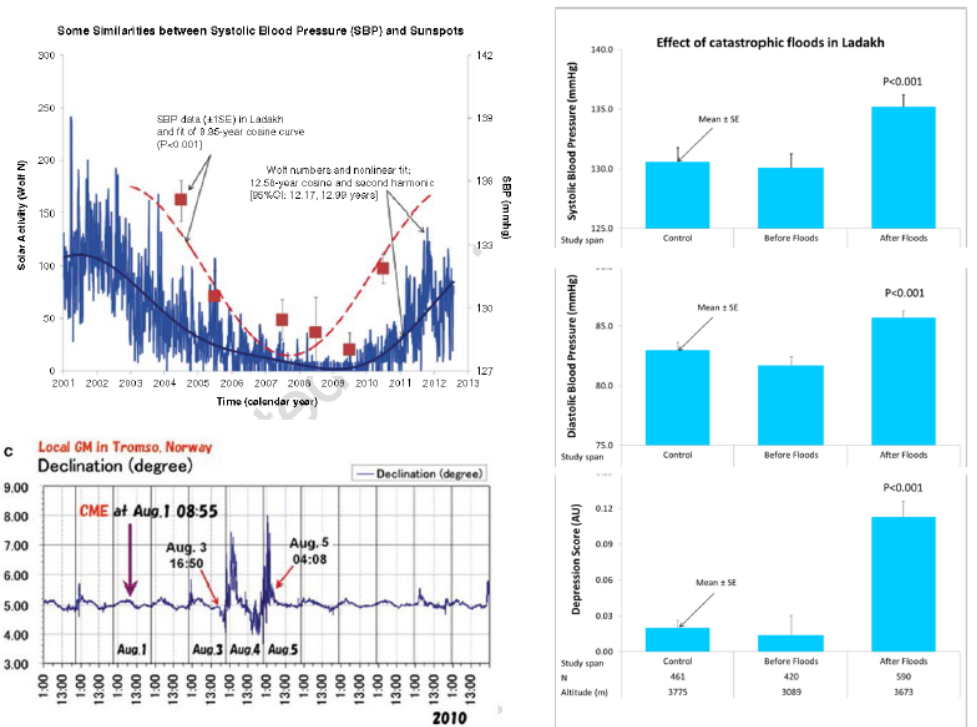
Figure 3. Systolic blood pressure follows an about 11-year cycle similar to that of solar activity in Ladakh (top left). A strong magnetic storm was followed by catastrophic floods in Ladakh (bottom left), where studies monitored the cardiovascular health of populations living at different altitudes.